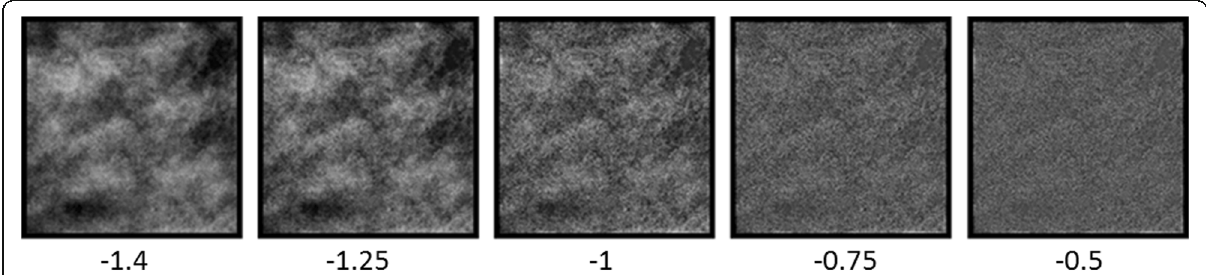
Fig. 1 Example of an original image patch from a mammogram classified as dense, along with sharpened versions created by altering the slope of the average amplitude spectrum from the original slope ( − 1.4) to a slope of −